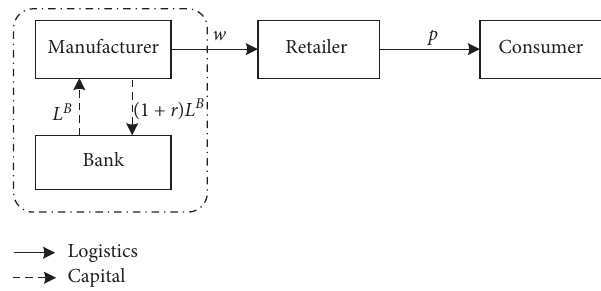
Figure 1: Supply chain operation and financing process under bank financing